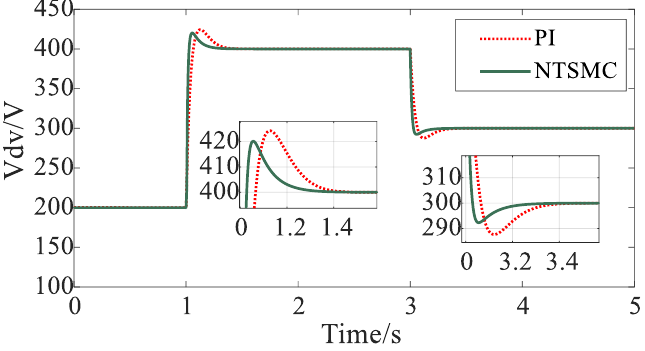
Figure 5. NTSMC and PI response performance comparison. Table 1. Performance analysis and comparison of NTSMC and PI.